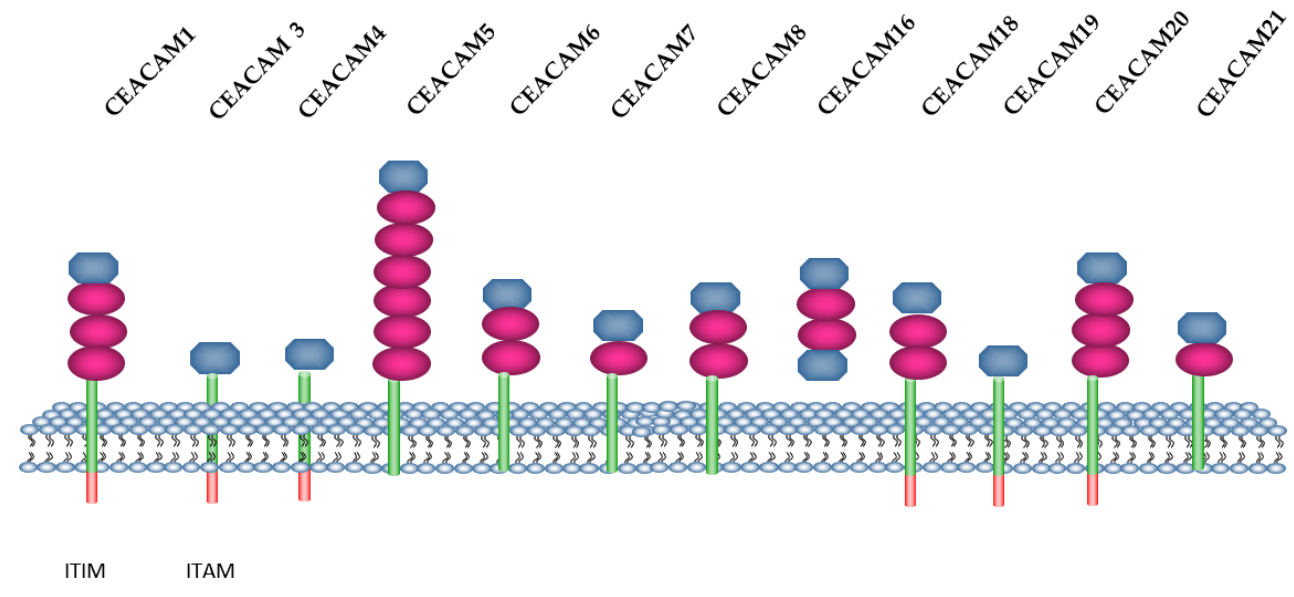
Figure 1. Schematic representation of human CEACAM isoforms. CEACAM belong to the immunoglobulin super family. They have at least one immunoglobulin-like domain Ig variable (IgV) and Ig constant (IgC). IgV and IgC are colored in blue and red, respectively, the cytoplasmic domain in orange and the GP-anchor in green. ITIM: immunoreceptor tyrosine-based inhibition motif. ITAM: immunoreceptor tyrosine-based activation motif (uniprot.org; proteinatlas.org) (accessed date 18 November 2021). Table 1. CEACAM Family Members (uniprot.org; proteinatlas.org) (accessed date 18 November